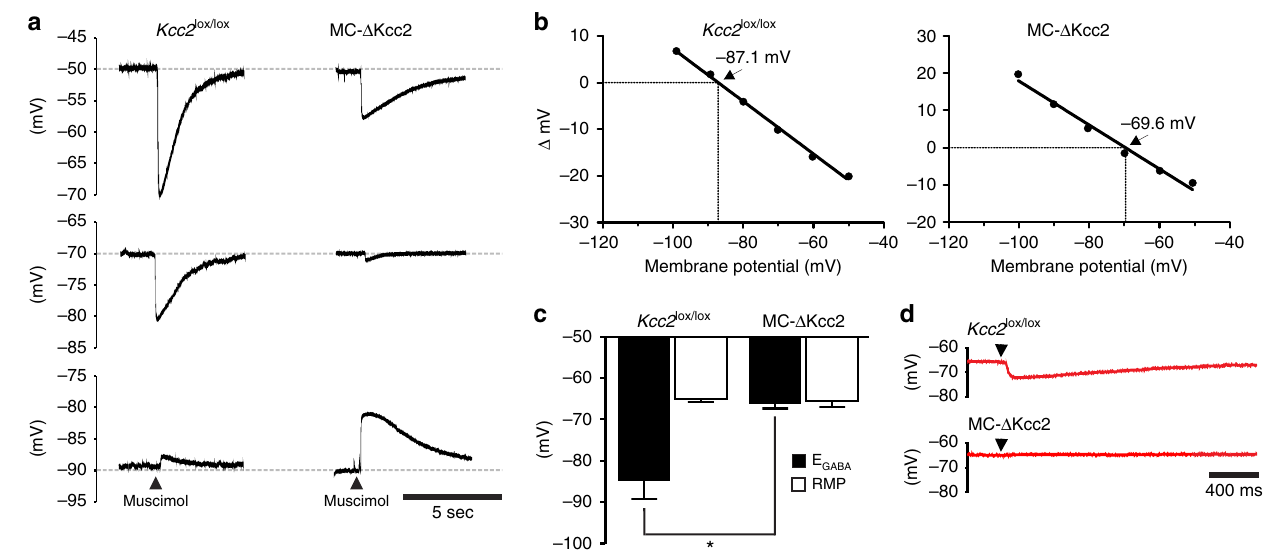
Figure 2 | Effect of Kcc2 disruption on E GABA in mitral cells. ( a ) Example traces of voltage responses of MCs from Kcc2 lox/lox and MC- D Kcc2 mice to muscimol measured in current-clamp mode. Cells were clamped to different resting membrane potentials by the injection of appropriate currents and muscimol was superfused by pressure application while keeping injected currents constant. ( b ) Linear regression analysis of muscimol-evoked responses ( D mV) as a function of different initial holding potentials from experiments as in a . The holding potential at which muscimol evoked no voltage response indicates E GABA (pointed out by arrows and numbers). ( c ) Averaged values of E GABA and RMP obtained from these experiments (every single cell yields both values). E GABA was significantly different between Kcc2 lox/lox and MC- D Kcc2 MCs (* P p 0.05, Mann–Whitney Test; Kcc2 lox/lox : 8 cells and MC- D Kcc2: 6 cells). RMP did not differ significantly between genotypes. ( d ) Example traces of MCs from Kcc2 lox/lox and MC- D Kcc2 mice measured in current clamp mode with I ¼ 0 (that is, at resting membrane potential). E GABA is below RMP values in Kcc2 lox/lox MCs, as indicated by hyperpolarizing response to muscimol, whereas almost no response is observed in MC- D Kcc2 MCs (that is, E GABA E